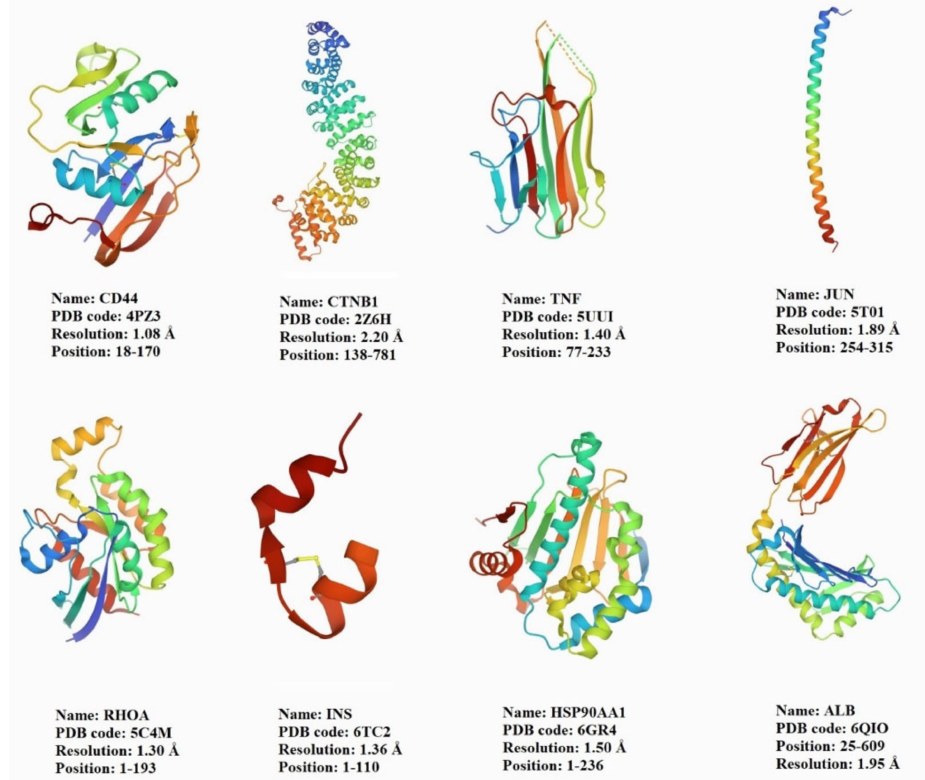
Figure 6. The structure of proteins encoded by 16 hub genes obtained from the RCSB PDB databases.